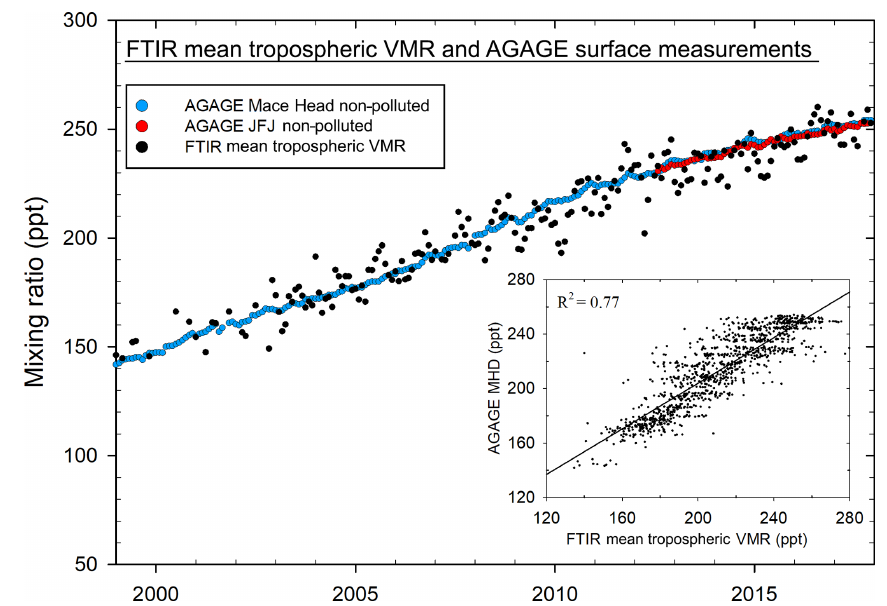
Figure 6. Tropospheric monthly time series at Jungfraujoch. The FTIR time series (black) is constructed by taking the average of all of the layers below 11.21km, the altitude limit objectively defined by the retrieval information content. AGAGE in situ time series from Mace Head (light blue) and JFJ (red) are baseline measurements (see Sect. 4.1.1). Daily coincidences between Mace Head and FTIR are depicted in the inset scatter plot. The coefficient of determination of the linear regression, R 2 , is 0.77 ( R = 0 . 88).